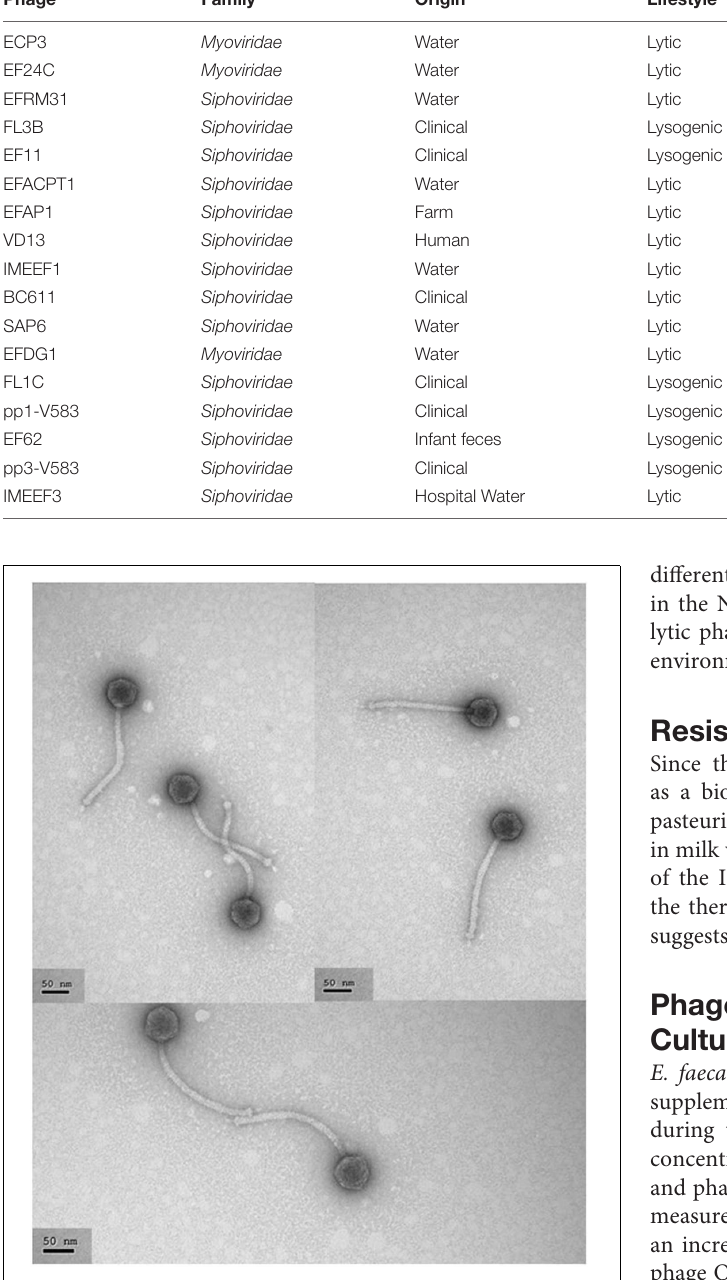
FIGURE 1 | Electron photomicrographs of phage Q69. Phage particles were prepared, negatively stained, and examined under the electron microscope as described in Section “Materials and Methods”. The scale bar represents 50